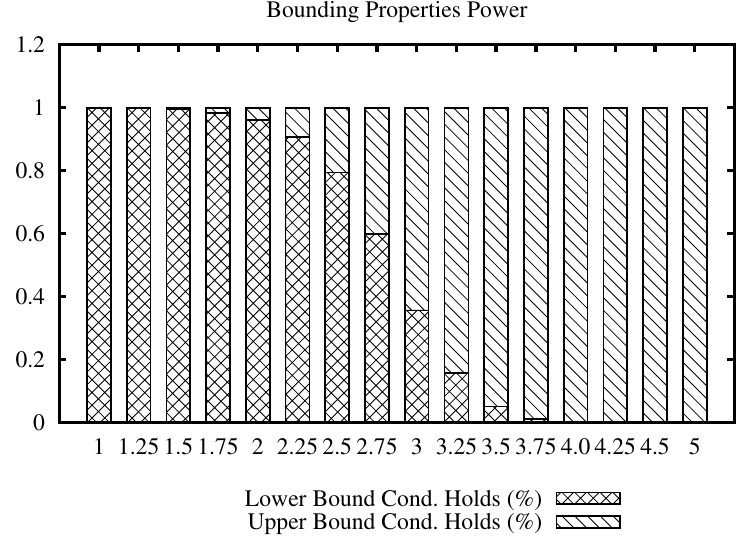
Figure 5. Percentage of filtering that each bounding property can achieve upon the range of radius of the join algorithm using the Points data set.